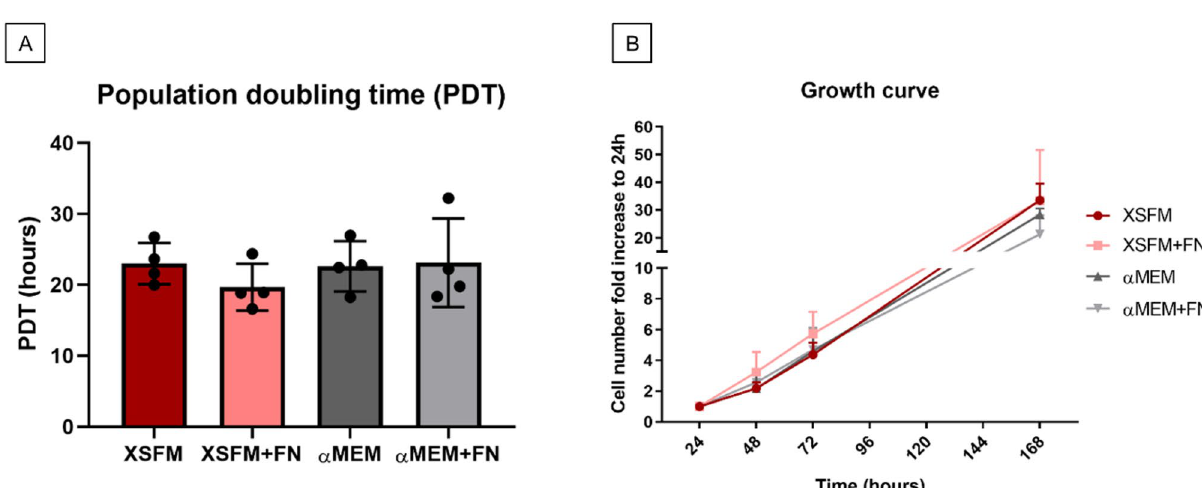
Figure 4. Cell growth and metabolic activity of BMSC cultured in αMEM/FBS/FGF2 (grey shades) or XSFM (red shades) up to 168 h (7 days). Tissue culture plastic was either pre-coated with 5 μg/ml fibronectin (light color lines and bars) or not (dark color lines and bars). ( A ) Comparison of BMSC doubling time (range 24–72 h) among the different groups, expressed in hours. ( B ) Growth curve indicating the average cell fold increase referred to 24 h after cell adhesion. n = 4